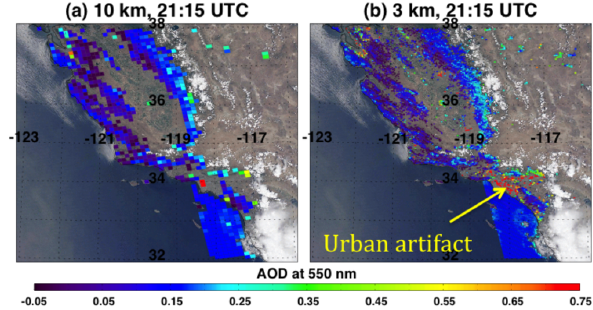
Fig. 6. Same as in Fig. 3 but for a situation over California where the 3km product introduces widespread artificial noise over an ur- ban area that the 10km product better confines. There were no col- locations with AERONET for this